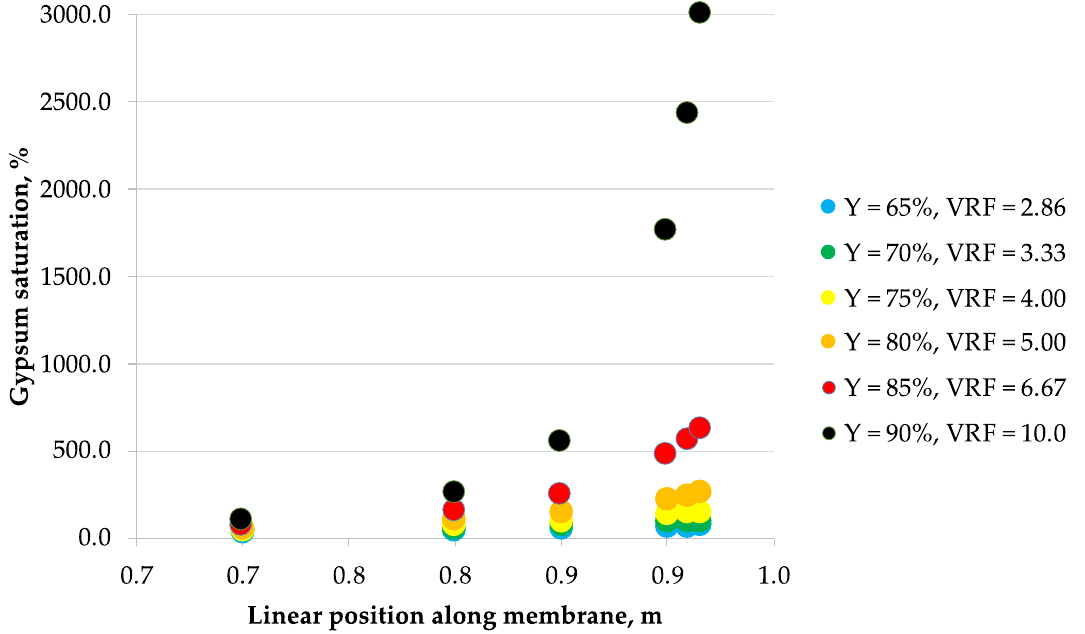
Figure 6. Saturation vs. position along the membrane for mine water A (0.384 g / L as Cl − , 1.02 g / L as SO 42 − , 0.107 g / L as Na + , 0.142 g / L as Mg 2 + , 0.312 g / L as Ca 2 + ) and NFDL nanofiltration membrane.